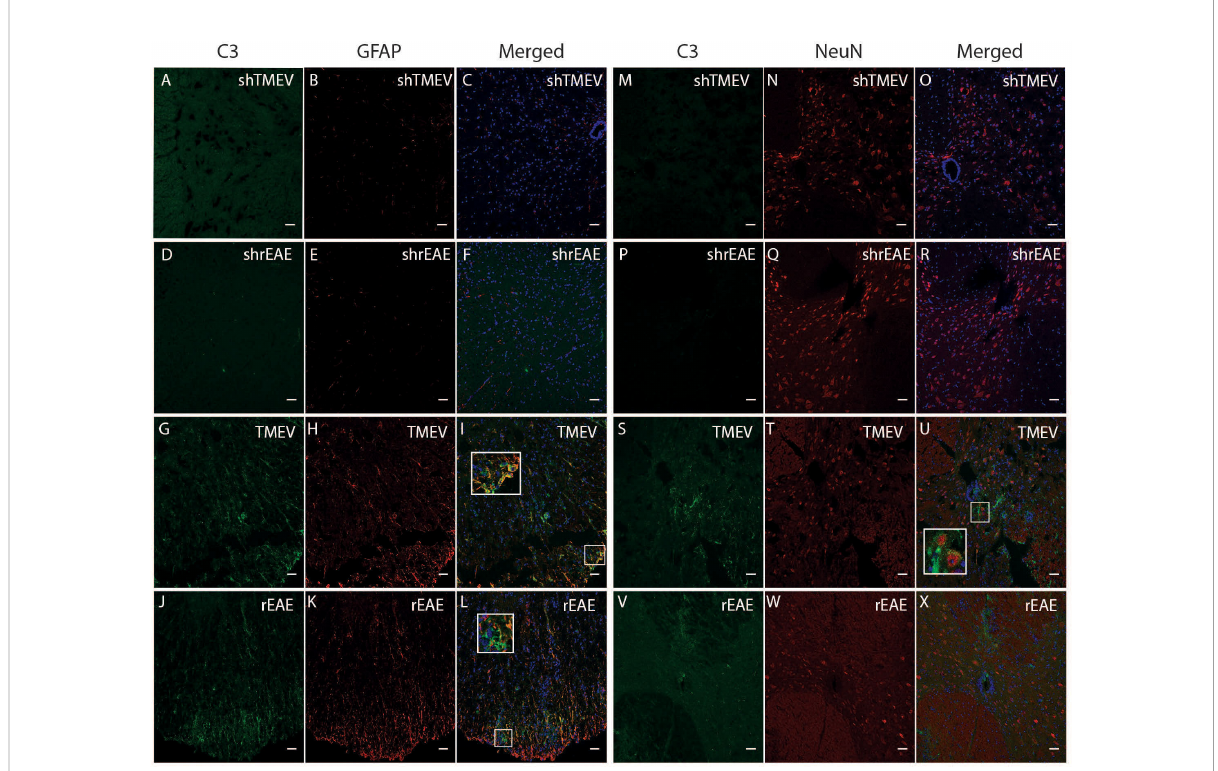
FIGURE 2 CColocalization of C3, GFAP and NeuN in the spinal cord of TMEV-IDD and rEAE mice. TMEV-IDD and rEAE mice were necropsied at ~120 dpi (chronic stage) and ~15 dpimm (acute relapse), respectively. Spinal cords were harvested for immunohistochemical analyses of the complement component C3 (A, M, D, P, G, S, J, V) , the astrocytic marker GFAP (B, E, H, K) and the neuronal marker NeuN (N, Q, T, W) . Age-matched sham controls (A, D, M, P) show no apparent C3 staining. In contrast, TMEV-IDD (G, S) and rEAE (J, V) show diffuse C3 deposits along the spinal cord. In TMEV-IDD, C3 (green) colocalizes with GFAP (red in I) and NeuN (red in U ), con fi rming an association between the complement system, reactive astrocytes, and neuronal cell bodies. In rEAE, we found that C3 (green) colocalizes with GFAP (red in L ) but not NeuN (red in X ), con fi rming, in these mice, an association of the complement system with reactive astrocytes but not neuronal cell bodies. Merge of C3 and GFAP (C, F, I, L) and C3 and NeuN (O, R, U, X) is shown with DAPI (Blue) for clarity of nucleus localization. Insets in images show white boxed areas at higher magni fi cation. Images are representative of 5-6 mice per group. Representative z stacks are shown and the scale bar = 100 m